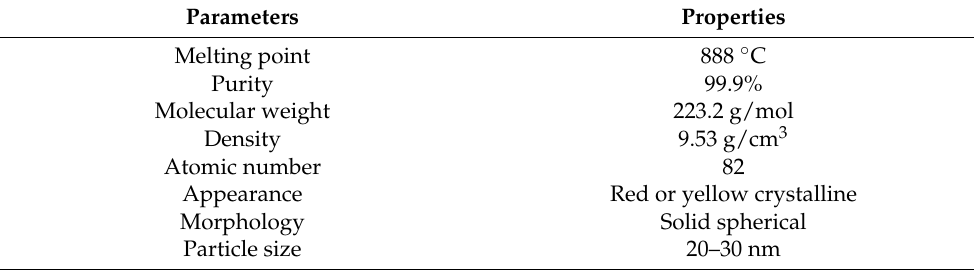
Table 1. Properties of the lead oxide nano-powder used in the study.